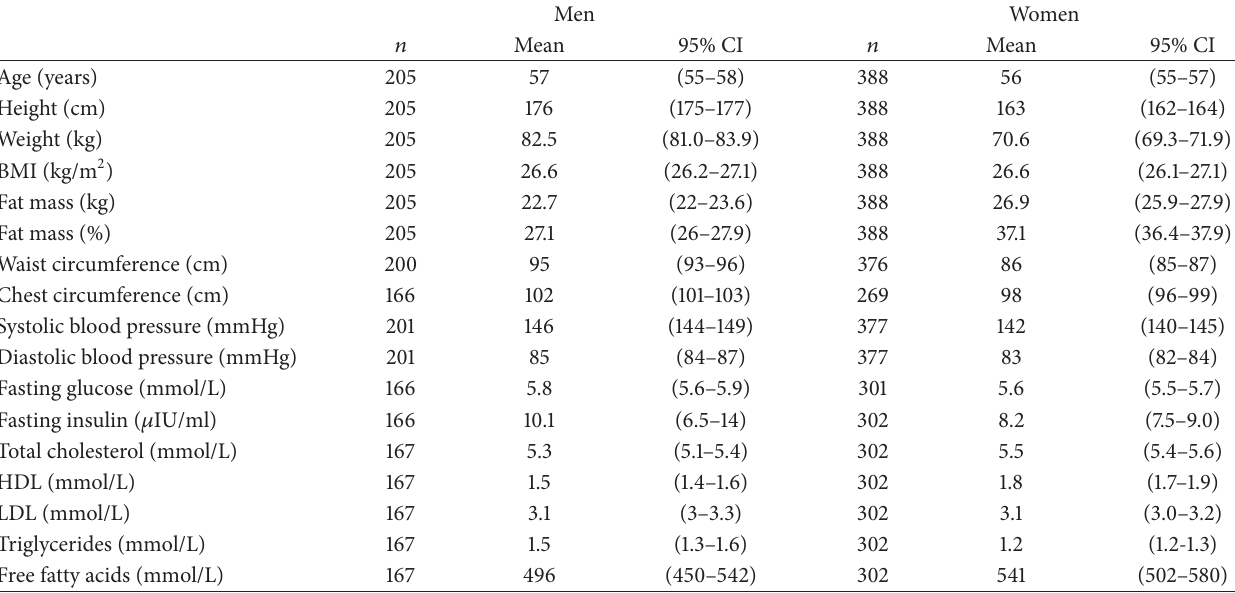
Table 2: Anthropometric and metabolic characteristics of the study